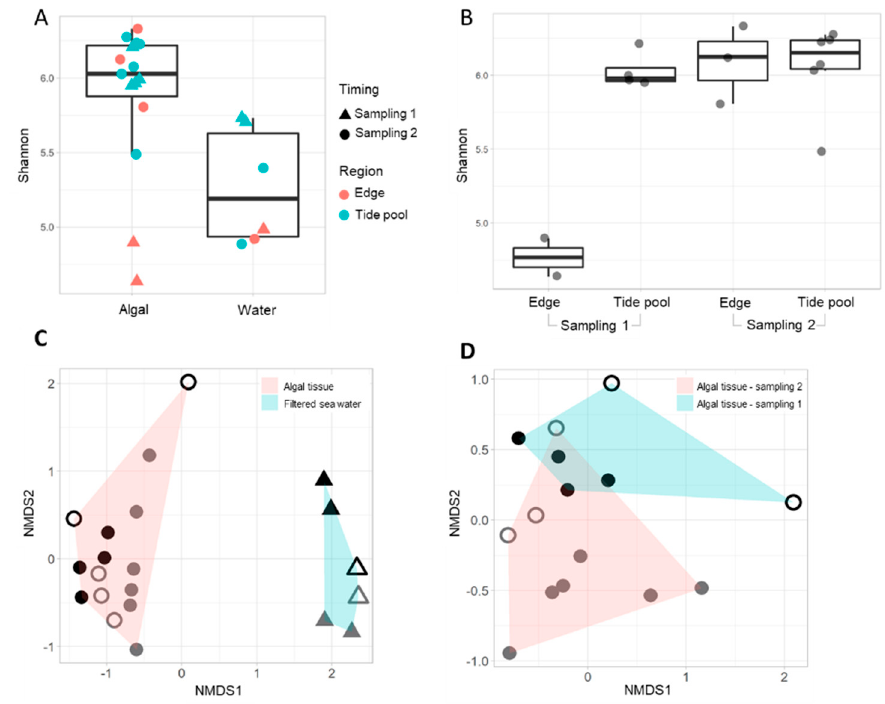
Figure 2. ( A , B ) Alpha diversity analyses calculated using the Shannon index of Neogoniolithon sp. surfaces and their surrounding water ( A ) in sampling 1 (triangles) and sampling 2 (circles), in different study regions (tidal pools, turquoise; platform edge, red). Water was collected from the same study region where the algal samples were collected. Significance was calculated using ANOVA and Tukey’s Honest Significant Difference method, p value = 0.0155. ( B ) Alpha diversity analysis of algal samples in tidal pools and platform edge. Significant differences were observed only for sampling 1 tidal pool–Edge ( p value = 4.8 × 10 − 4 ) and sampling 1–Edge–sampling 2–Edge crossings ( p = 9.2 × 10 − 3 ). Other alpha diversity indices demonstrated similar trends, see Figure S3. ( C ) NMDS analyses with Bray–Curtis distance (stress value 0.091) for algal and water samples. A significant difference between community structure of algal and water samples was observed (PERMANOVA, p value = 0.001). ( D ) NMDS analyses with Bray–Curtis distance (stress value 0.1104) for algal samples in samplings 1 and 2. Samplings 1 and 2 also demonstrate distinct com- munity structures ( p value = 0.002). ( C , D ) Circles, algal samples; triangles, water samples; closed symbols, tide pools; empty symbols, edge; during sampling 1 (black) and sampling 2 (grey). Prokaryote samples withdrawn from natural Neogoniolithon sp. surfaces were domi- nated by Proteobacteria (49.09 ± 11.66%), Bacteroidota (25.22 ± 12.64%), Cyanobacteria (5.33 ± 3.83%), and Actinobacteriota (4.73 ± 2.60%), (Figure 3, the complete list is provided